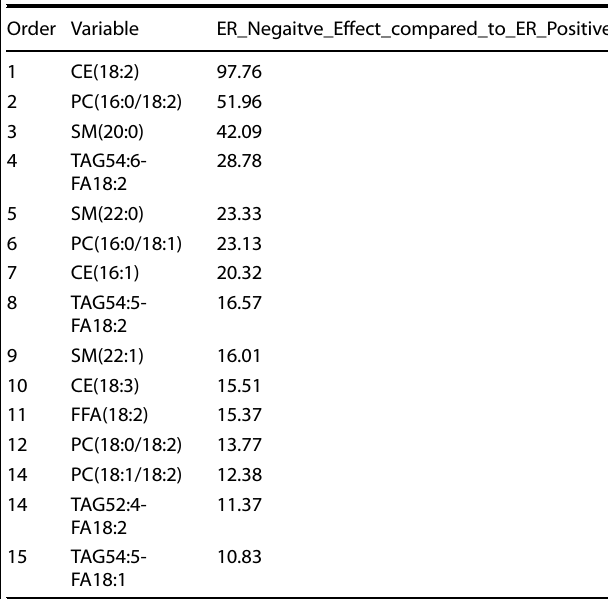
Table 1. Lipid species in the serum of CUB patients ranked by effect size, ER negative compared to ER positive.